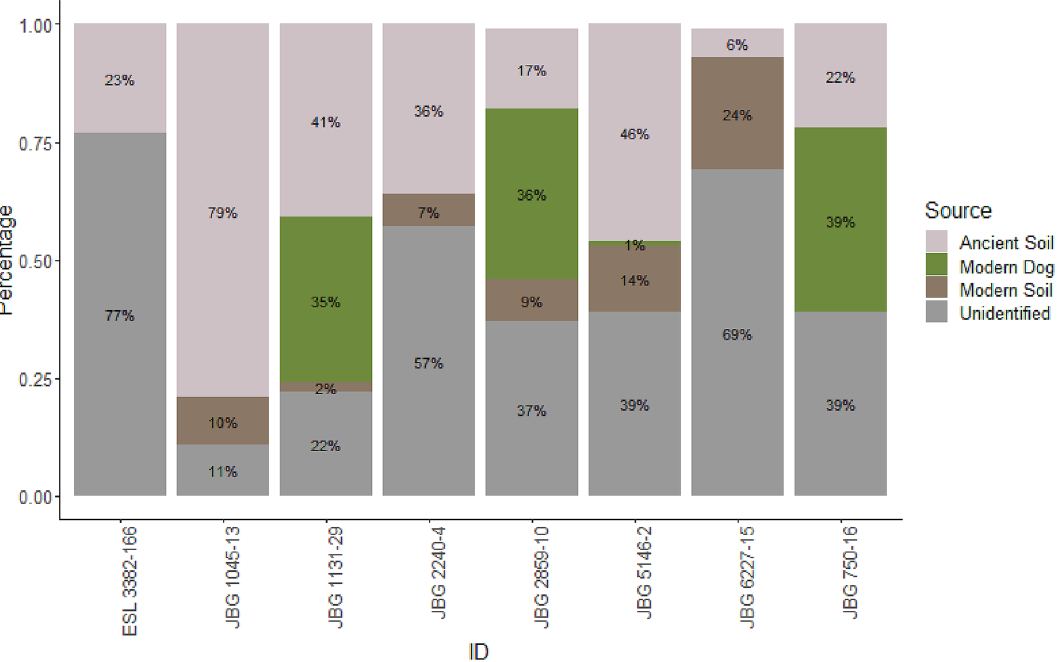
Figure 2. SourceTracker results, indicating soil sources and matches to modern fecal microbiome in the coprolites. The unidentified portions represent reads that could not be assigned to one of the listed sources (soil contaminants and the modern dog microbiome). This plot was created in R v. 4.0.2 111 using ggplot2